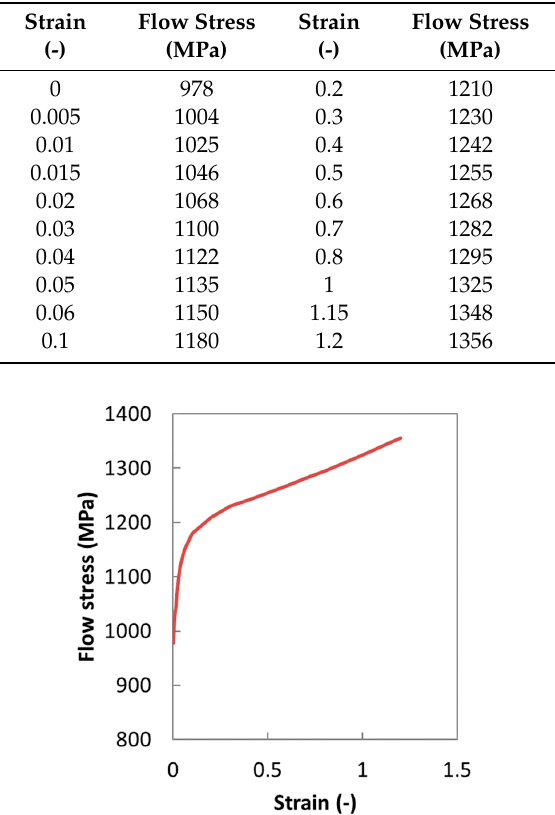
Table 3. Flow stress data in a tabular form.